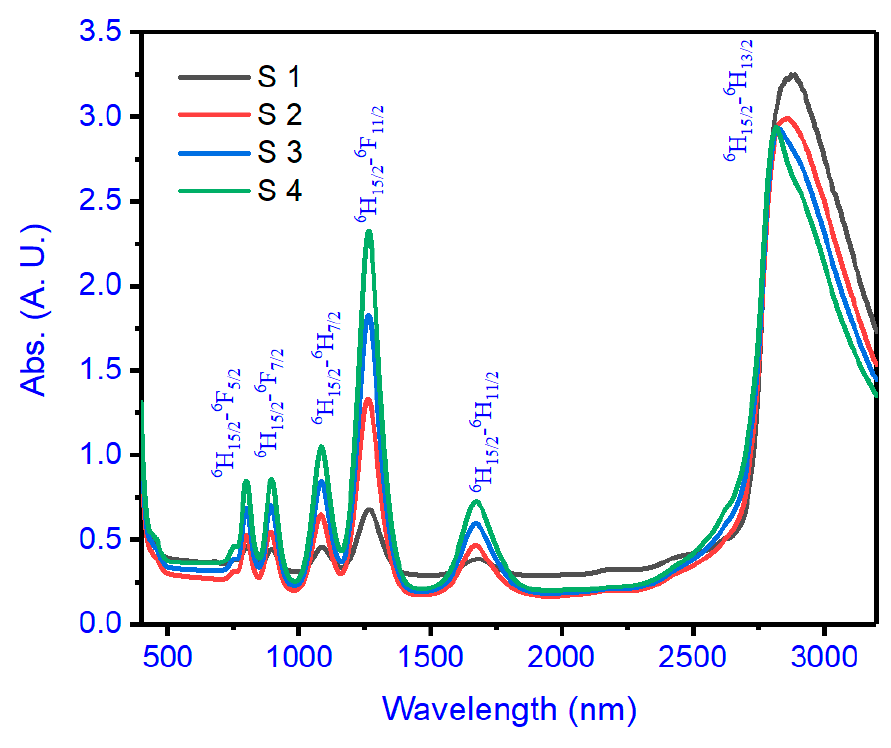
Figure 1. Absorption spectra of glass compositions (S1–S4) with their transitions.